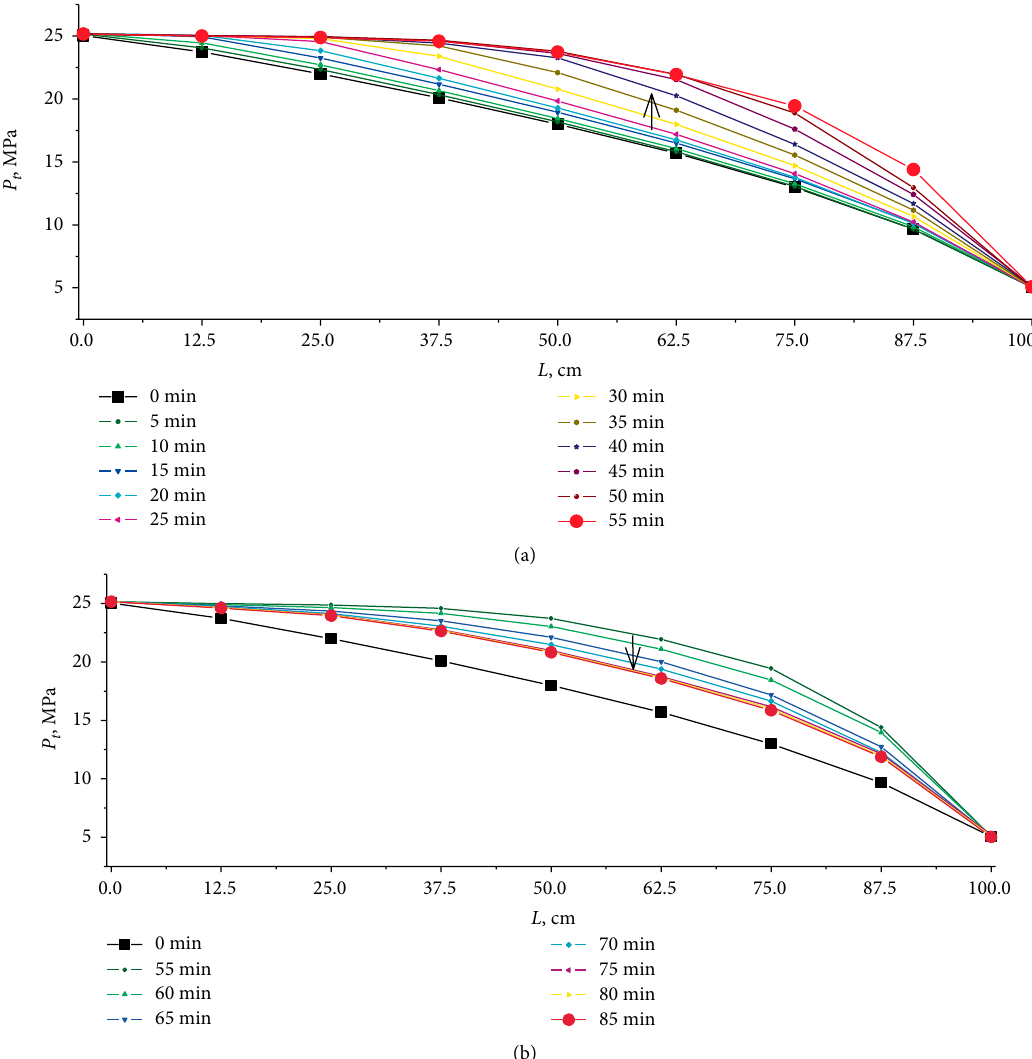
Figure 18: The pressure distribution in tight sandstone samples during CO